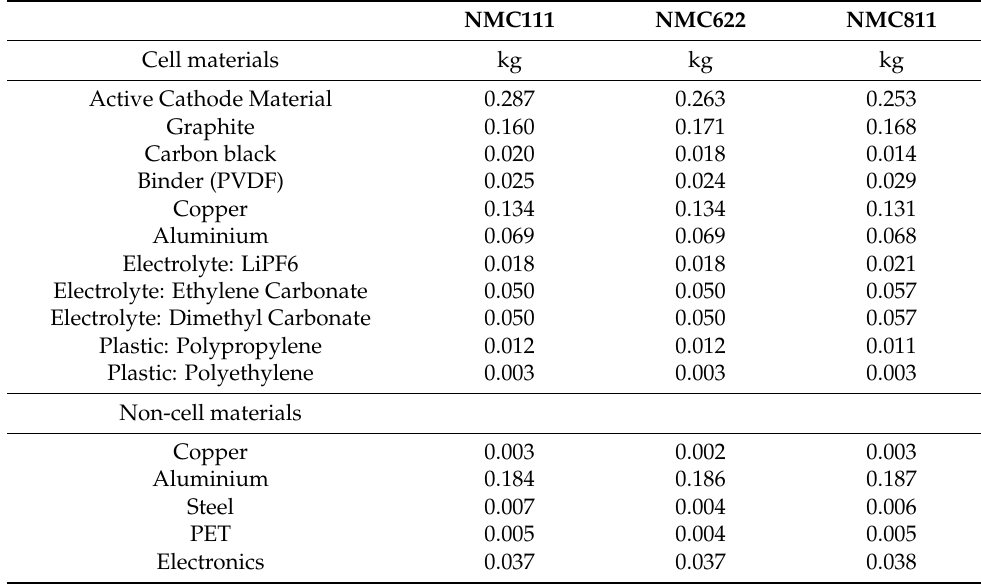
Table 2. Bills of materials (BOMs) of three types of NMC batteries per kg of battery